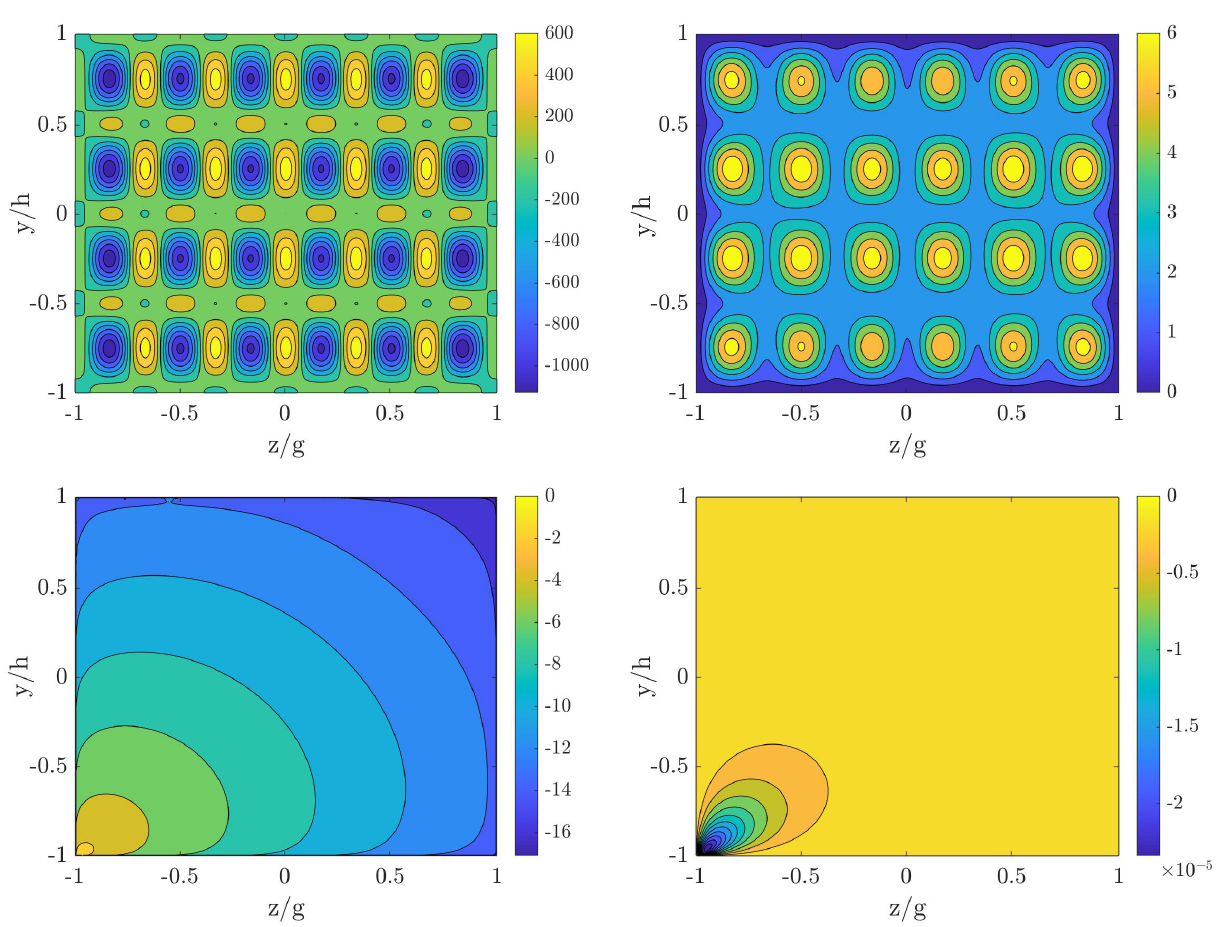
( | V − V test | / (cid:107) V test (cid:107) 10